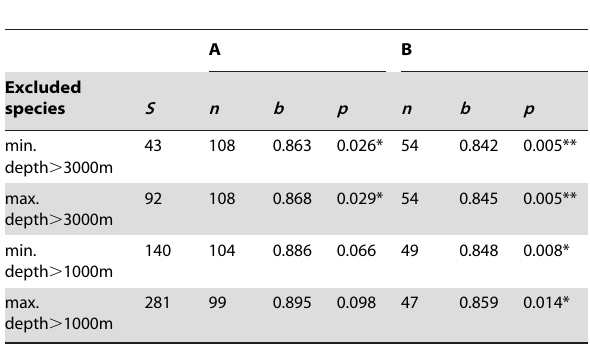
Table 2. Gastropod body size evolution above the abyssal or bathypelagic